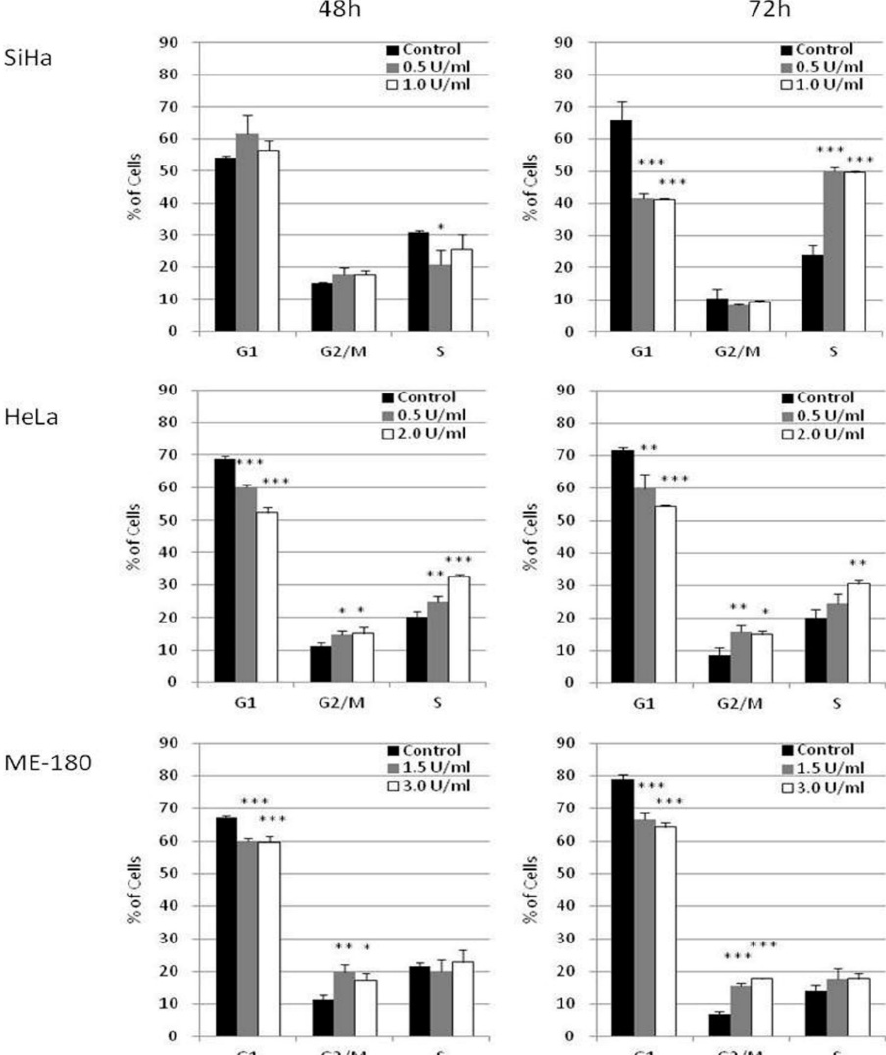
Figure 5. BCA-M induced cell cycle arrest in SiHa, HeLa and ME-180 cells. The e ff ects of BCA-M on cell cycle phase distribution were determined using flow cytometric analysis with propidium iodide (PI) staining and RNase digestion. The results for percentage of cells in G 1 , G 2 / M and S phases were shown as means and S.D. One-way ANOVA indicated significant phase arrestment at S phase for SiHa cells, G 2 / M and S phases for HeLa cells and G 2 / M phase for ME-180 cells with post hoc Dunnett’s test showing p values for comparison between control and treatment as: * p < 0.05, ** p < 0.01, *** p < 0.001. To further understand the mechanism of BCA-M-induced cell cycle arrest, the transcriptional regulations of cyclin genes were analyzed using quantitative real-time PCR (Figure 6). The expression levels of cyclin A1 (CCNA1) were studied for HeLa and ME-180 cells while that of cyclin A2 (CCNA2) was studied for SiHa cells. The expression levels of cyclin B1 (CCNB1), cyclin D1 (CCND1) and cyclin E1 (CCNE1) were also determined for all these cell lines. For SiHa cells, BCA-M treatment resulted in the significant down-regulation of cyclin B1 expression after incubation for 72 h with both tested concentrations. For HeLa cells, 2.0 U / mL of BCA-M treatment significantly down-regulated the gene expressions of cyclin B1 and cyclin E1, with concomitant up-regulation of cyclin A1 and cyclin D1 after incubation for 48 and 72 h. For ME-180 cells, BCA-M significantly down-regulated cyclin B1 expression after treatment for 48 and 72 h with both tested concentrations. There was also a slight down-regulation of cyclin E1 and up-regulation of cyclin A1 expressions at both 48 and 72 h with or without statistical